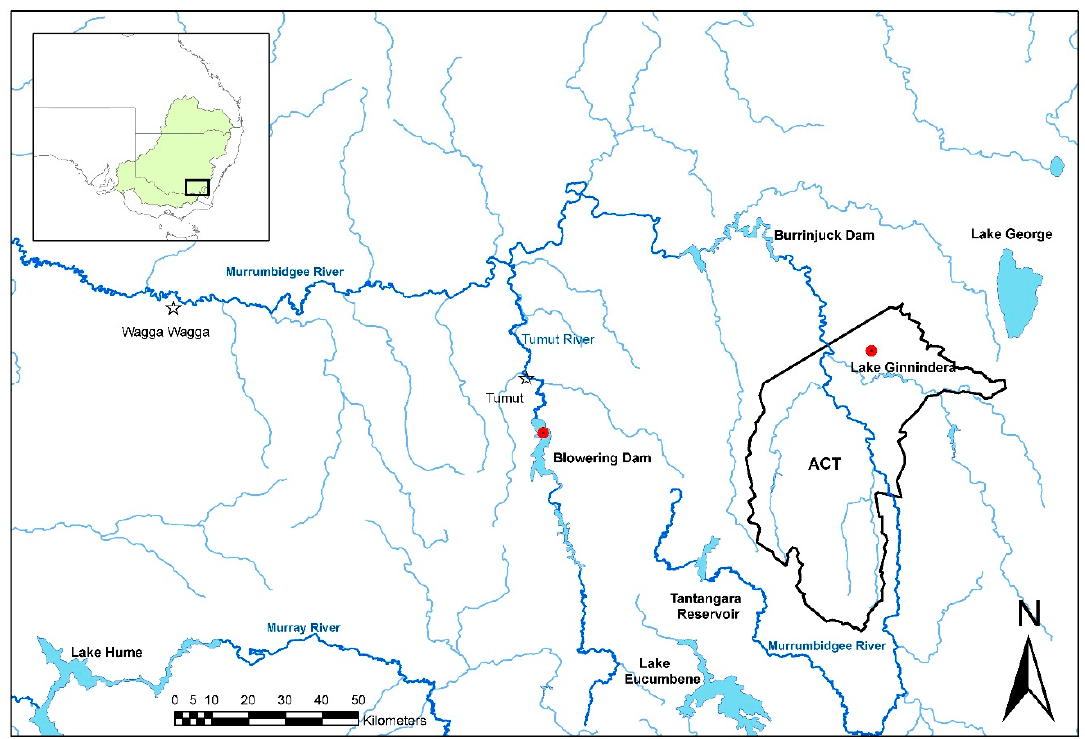
Figure 4. Moribund and dead redfin perch collected from Lake Ginnindera, ACT in December 2008 and 2010, and Blowering Dam, NSW in December 2009 were infected with